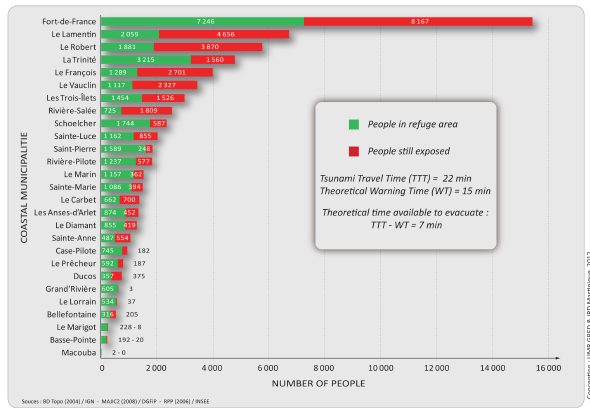
Fig. 4. Estimated number of people per municipality who could (green) or who could not (red) reach a safe zone in less than 7min on foot in case of tsunami generated from Barbados accretional prism (night population located under 10ma.s.l., 20m high shel- ter scenario).